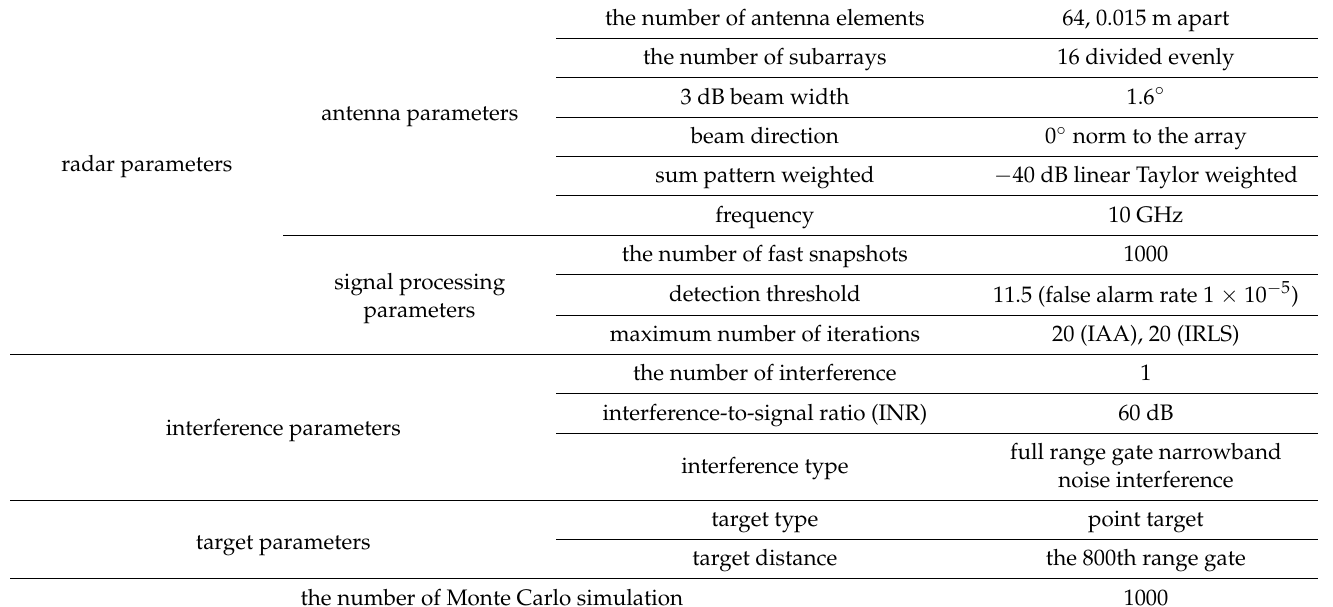
Table 3. Simulation parameters.